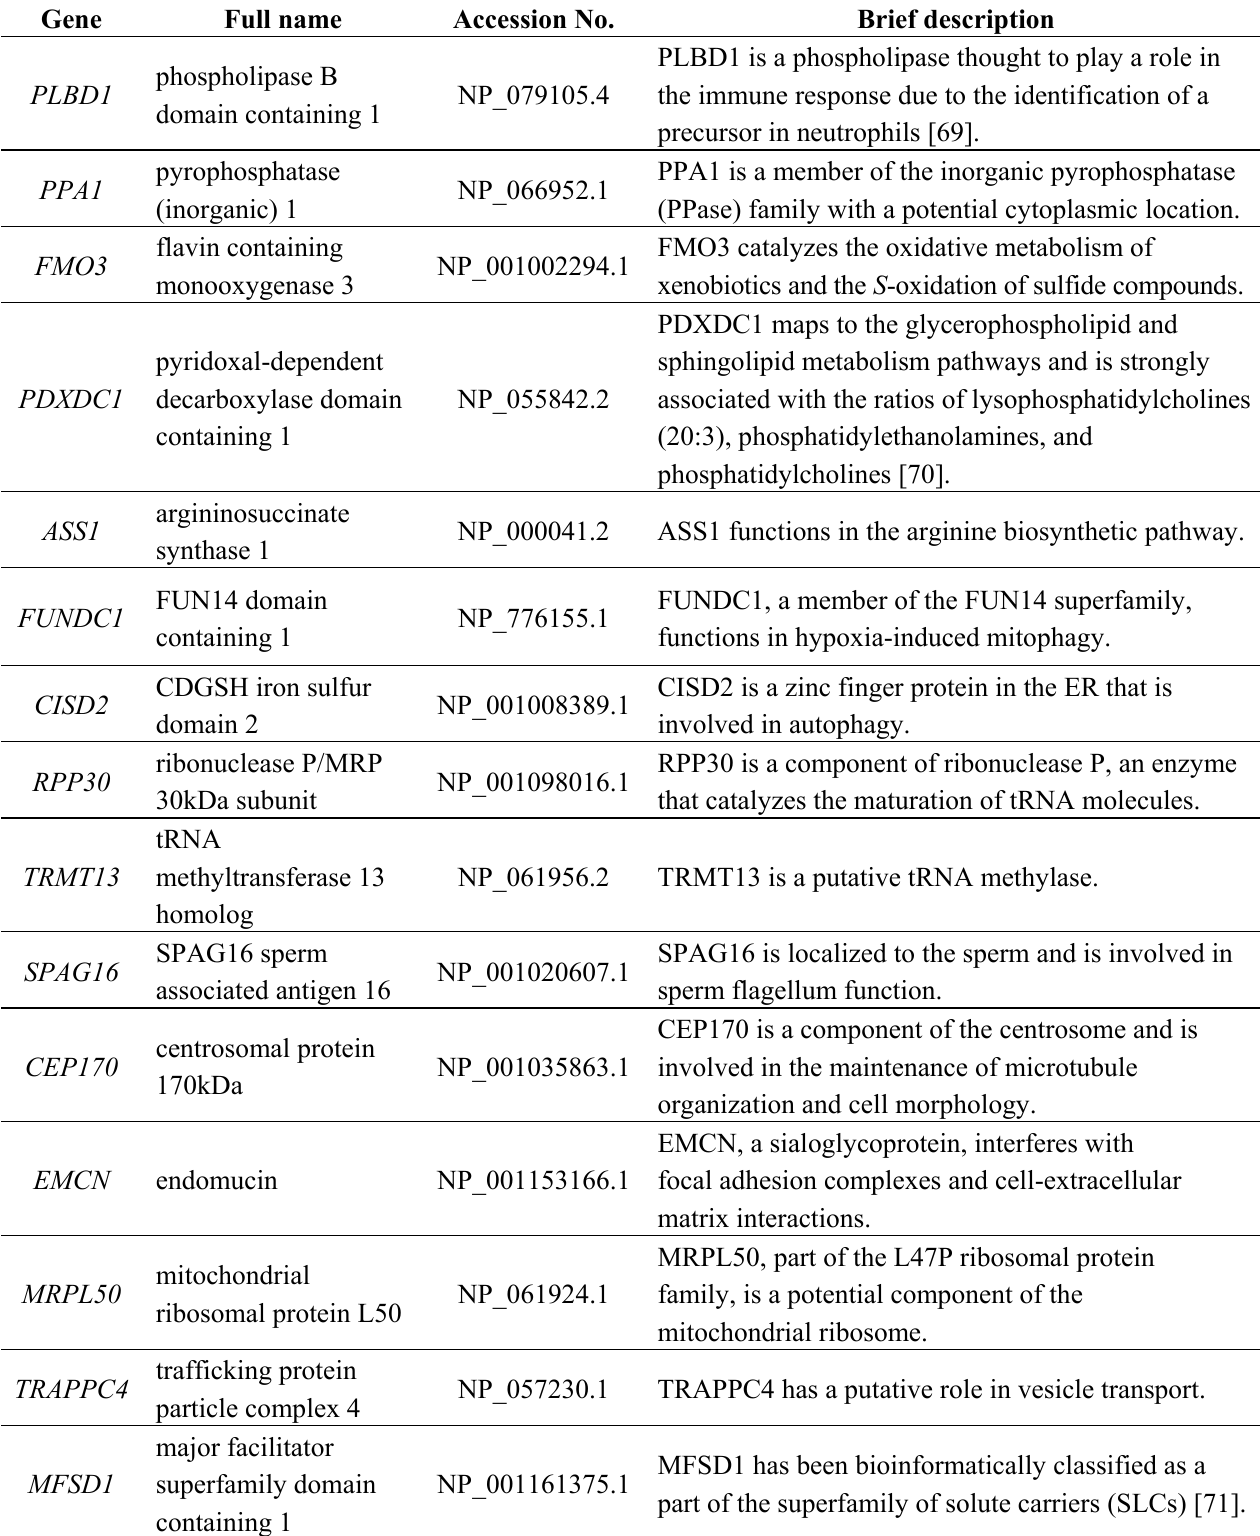
Table 5. Metabolism (15